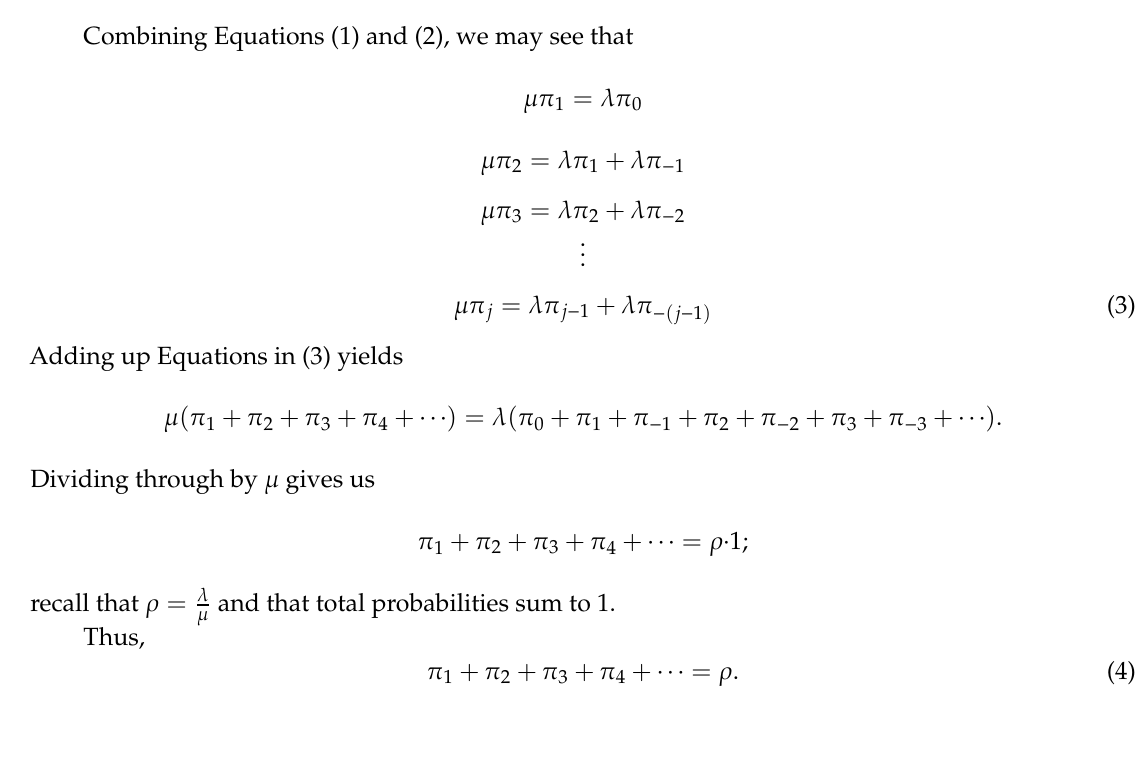
Figure 2. A rate diagram for the continuous-service M/M/1 queueing system with a cut.